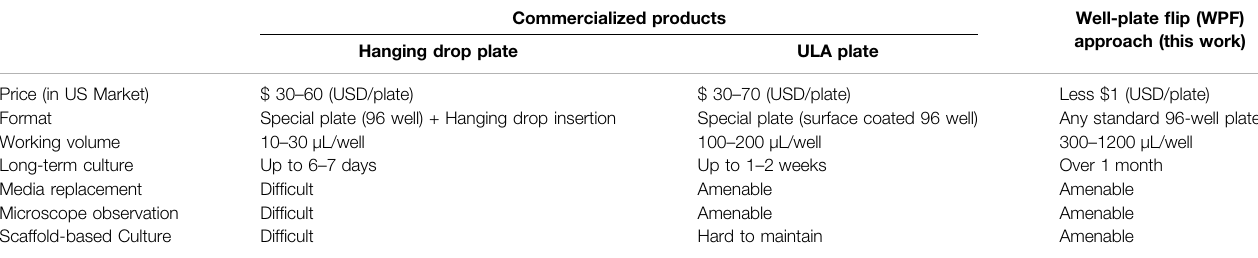
TABLE 2 | Comparison of 96-well-based commercialized product [Hanging drop plate and Ultra-low attachment (ULA) plate] and our well-plate fl ip